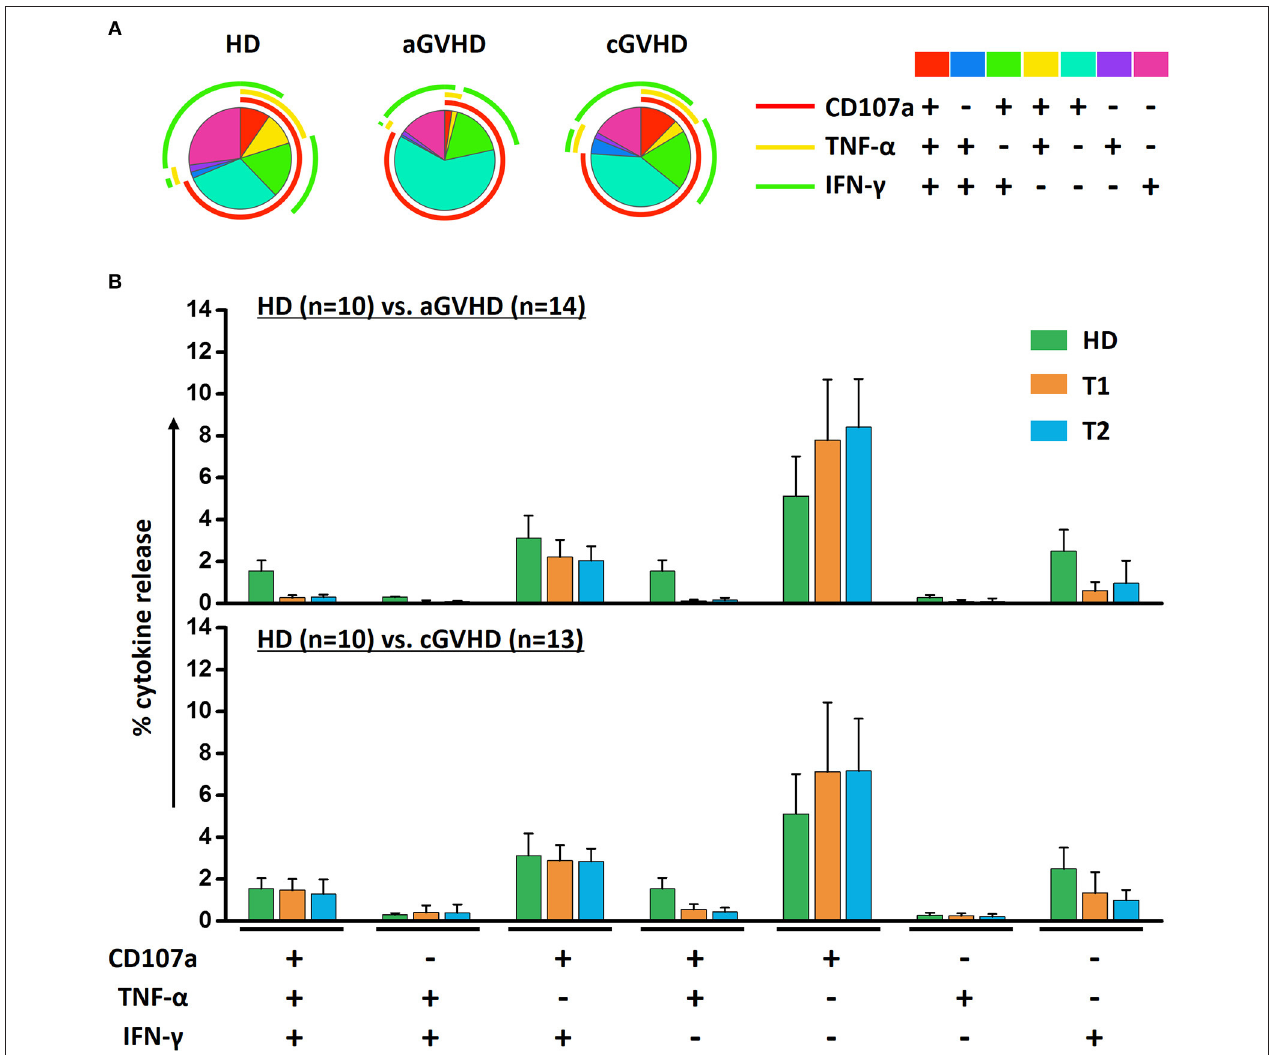
FIGURE 8 | Effects of ECP on the multifunctional NK cells. The polyfunctional NK cells were analyzed using Boolean gating strategy. The pattern of multifunctional NK cells was different among HDs ( n = 10), aGVHD ( n = 14, excluding patient #5 and #8 due to the limited cell number of samples) and cGVHD ( n = 13, excluding patient #17, #18, #21, #22, and #25 due to the limited cell number of samples) patients (A) . After long-term ECP treatment, the polyfunctional NK cells could keep stable (B)